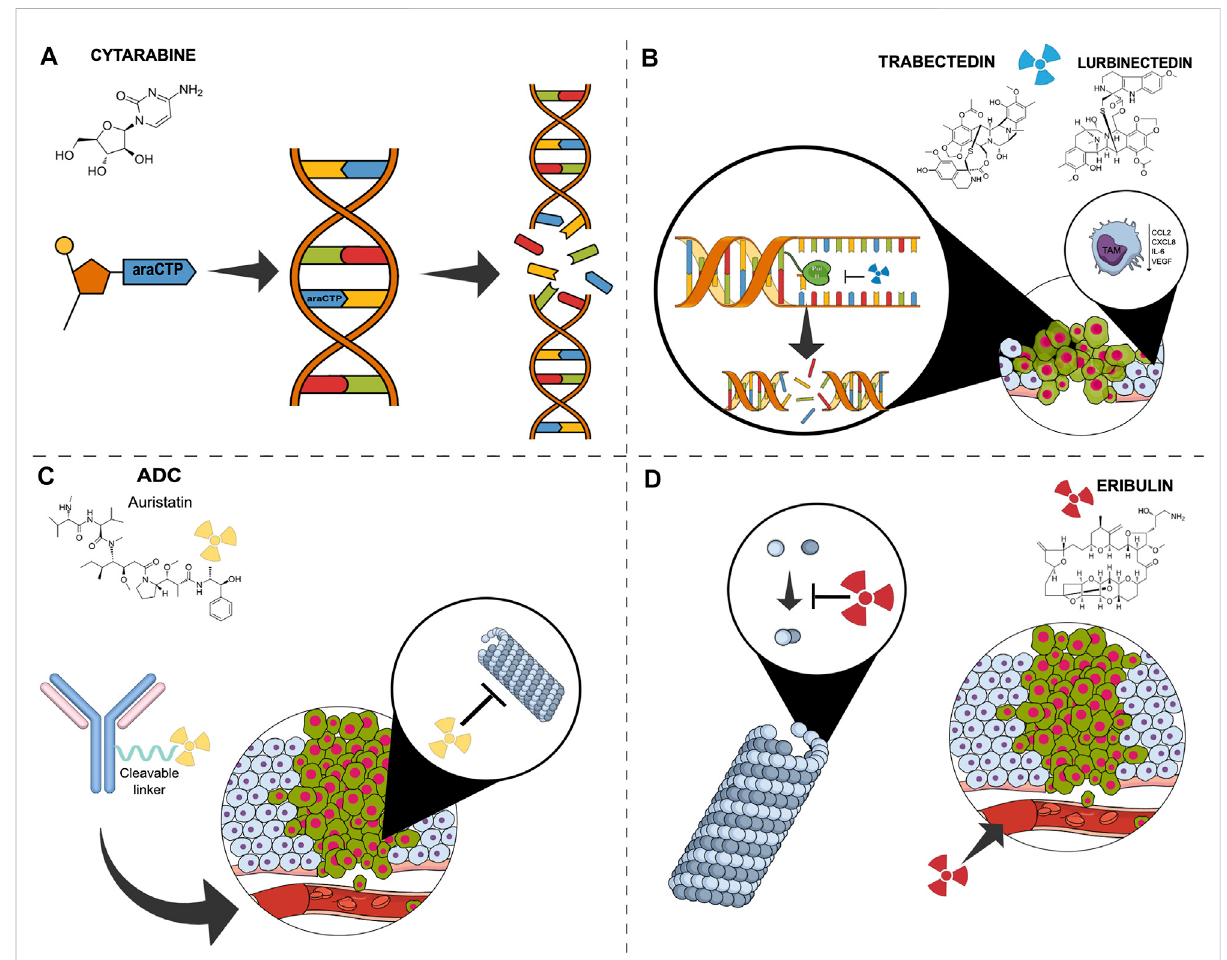
FIGURE 1 Simpli fi ed mechanisms of action of marine derivate compound in breast cancer. (A) Cytarabine is incorporated into DNA as its activated form, ara-cytidine 5 ′ -triphosphate, and promotes abnormal fragment binding of newly synthesised DNA, leading to apoptosis. (B) Trabectedin and Lurbinectedin bind to the minor groove of DNA inhibiting transcription, resulting in double-strand DNA breaks and cell death. They also affect the tumour microenvironment by negatively modulating tumour-associated macrophages ’ activity. (C) Antibody-drug conjugates consist of a monoclonal antibody boundto apayload, generally monomethylauristatin E, a cytotoxic compound that binds to tubulin, leading to both disruption ofmitoticspindleassemblyandarrestoftumourcellsinthemitoticphaseofthecellcycle. (D) Eribulininhibitsthemicrotubulegrowthphaseforming non-productive tubulin aggregates. It also acts on angiogenesis. Abbreviations: ADC, antibody drug conjugate; ara-CTP, ara-Cytidine-5 ′ - triphosphate; CCL2, C-C Motif Chemokine Ligand 2; CXCL8, C-X-C Motif Chemokine Ligand 8; DAR, Drug-antibody Ratio; EGFR2, epidermal growth factor receptor; IL6, Interleukin 6; mgDNA, minor groove DNA; MMAE, monomethylauristatin E; RNApol, RNA polymerase; TAM, tumor- associated macrophages; tc-NER, Transcription-coupled nucleotide excision repair; VEGF, Vascular-Endothelial Growth